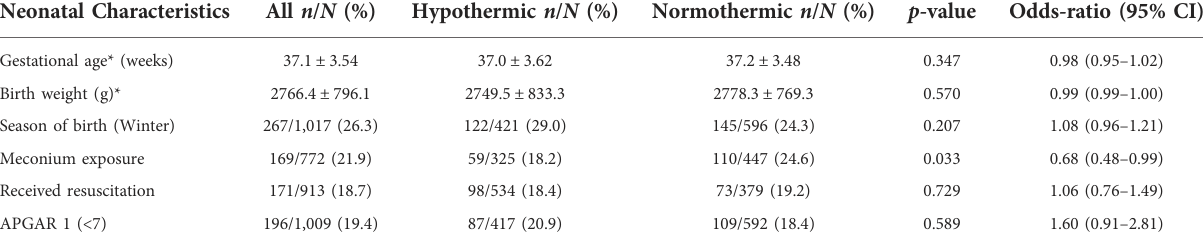
TABLE 3 Characteristics of neonates enrolled in study.